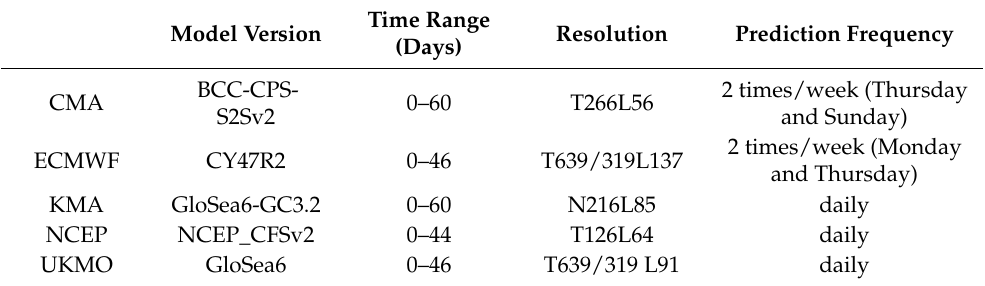
Table 1. Basic information of five selected models participating in the S2S project